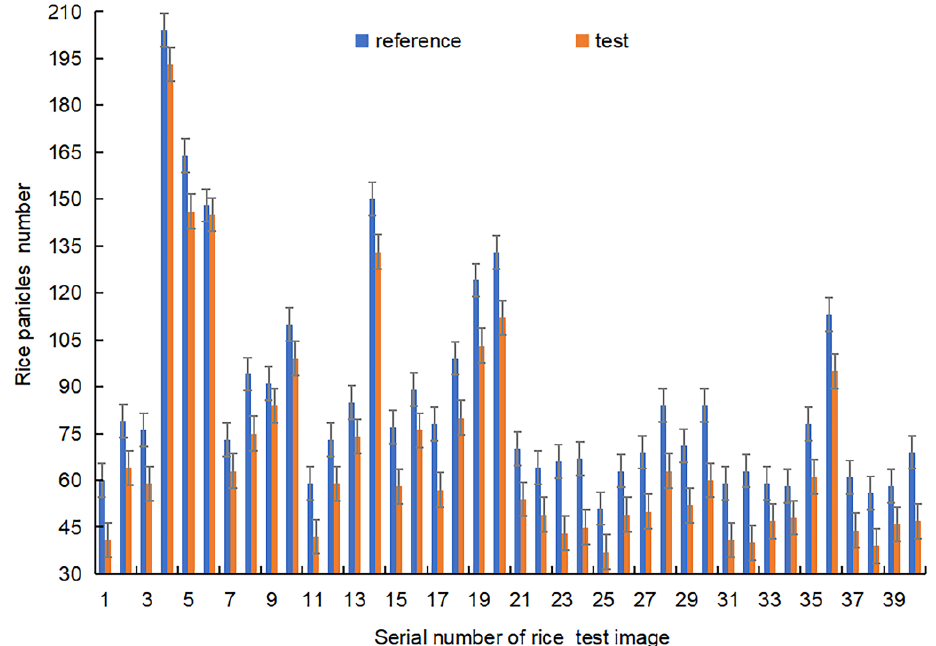
Figure 9. Comparison of the results of the number of rice panicles.